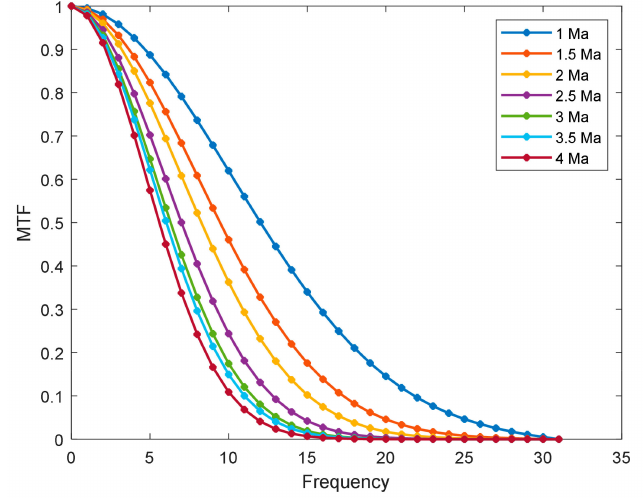
Figure 9. Variations in MTF results with different